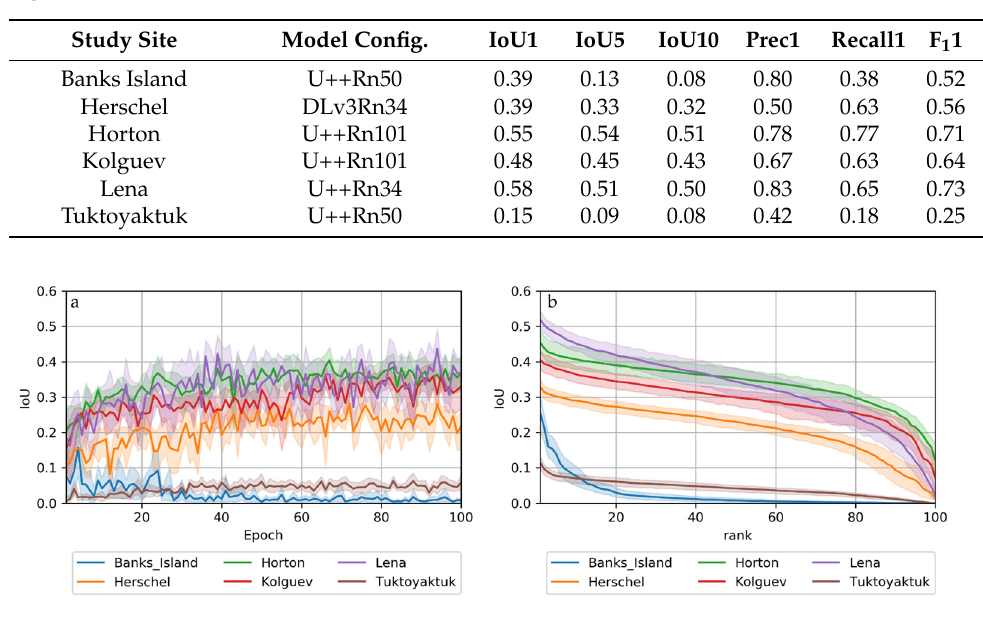
Figure 4. Mean and standard deviation of IoU scores per site sorted by ( a ) epoch and ( b ) scores (best to worst). n = 9 (3 sites × 3 encoders) per region.